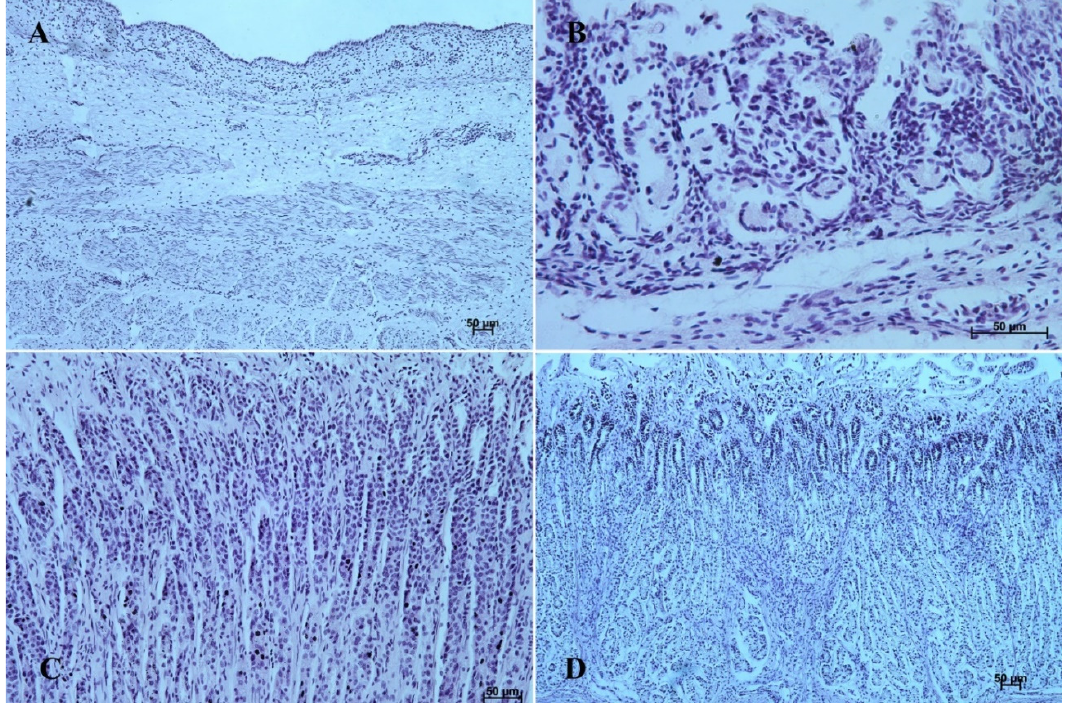
Figure 6. Histological structure of stomach mucosa in the pyloric part (hematoxylin-eosin staining). ( A )—the first age group (20×); ( B )—the second age group (10×); ( C )—the third group (20×); ( D )—the reference adult group (10×).